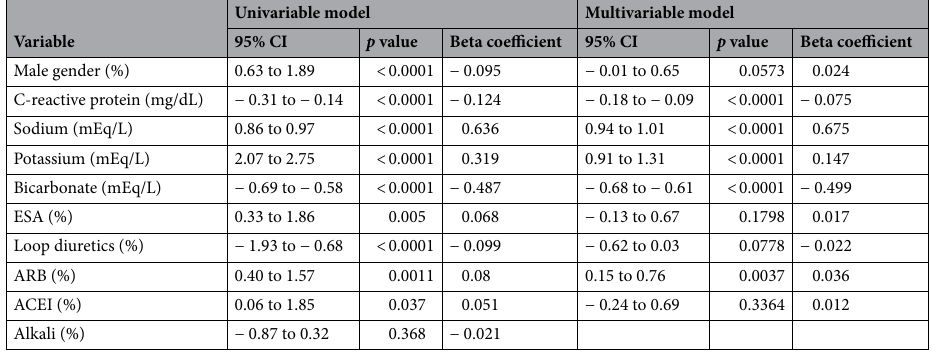
Table 5. Univariable and multivariable regression analysis of serum chloride.